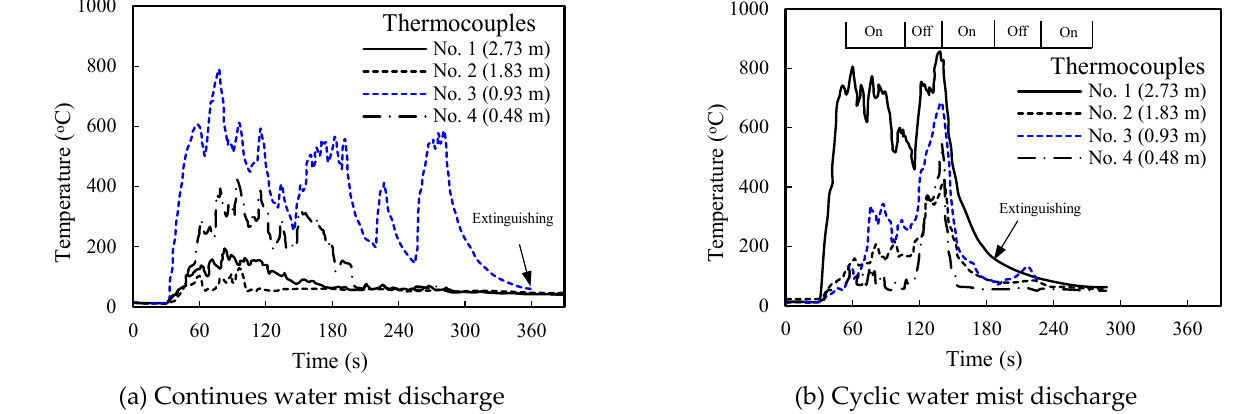
Figure 22. Temperature over a round-pan fire with different water mist discharge rates [57].